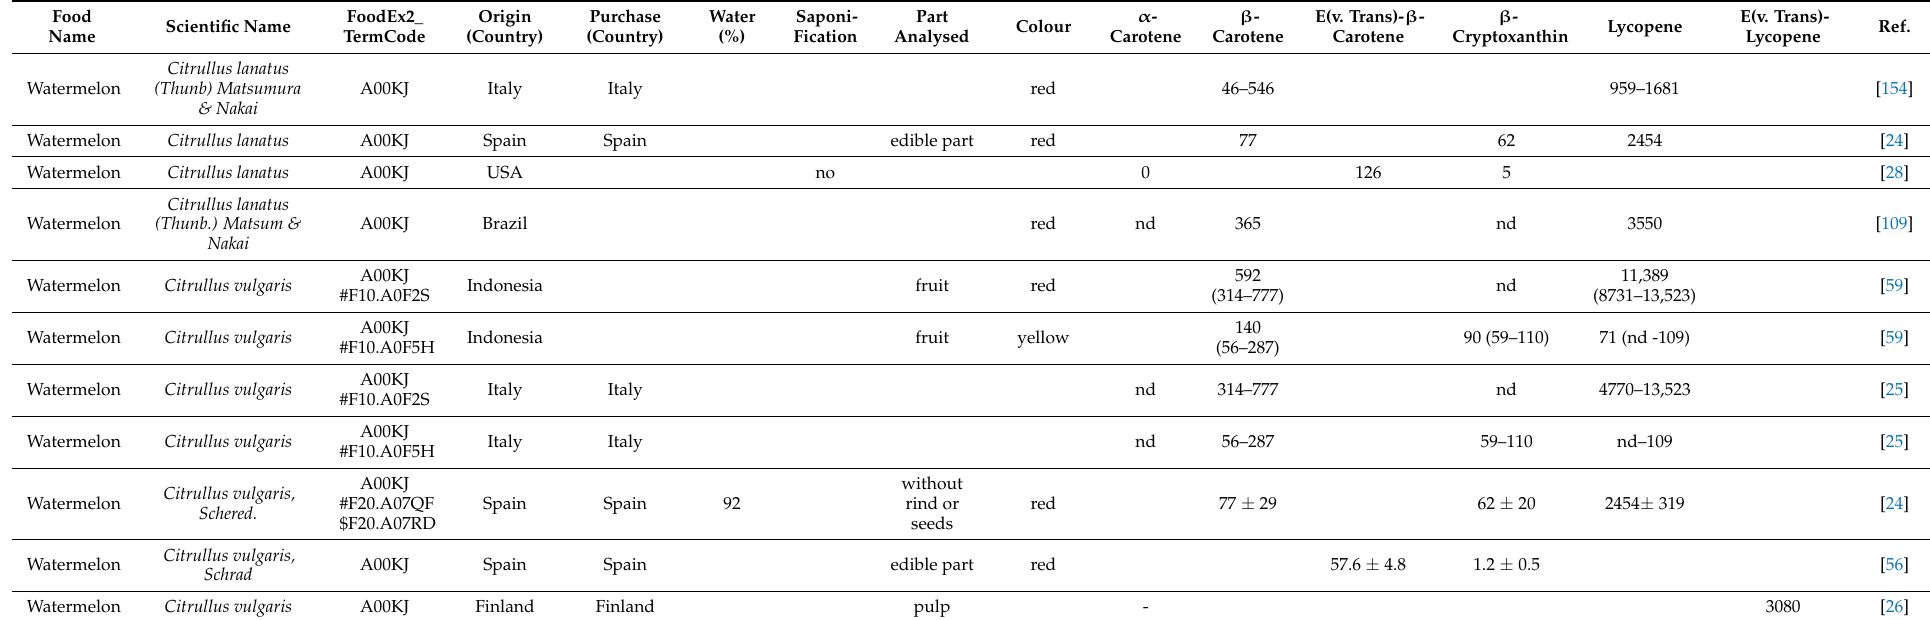
Table A8. Cucurbits with inedible peel (A00KD) ( µ g/100 g).